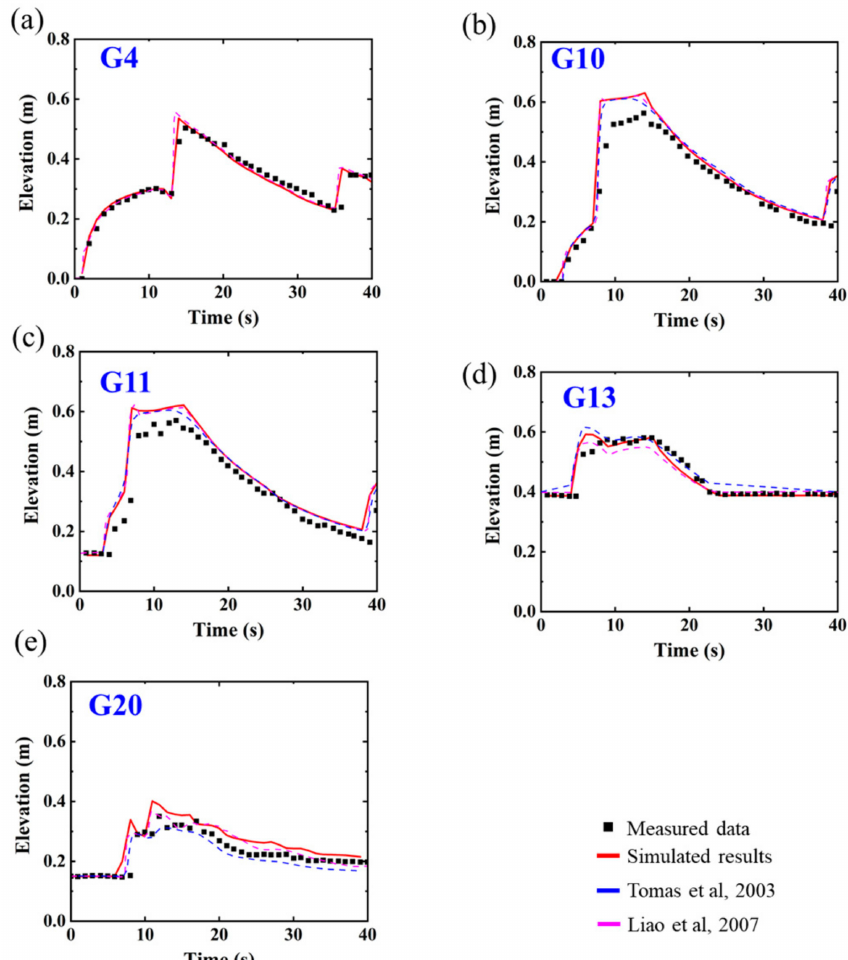
Figure 10. Monitored data compared with the simulated results at the four locations. ( a ) The simulated result is similar to the measured data at G4; ( b ) initially, the simulated results at G10 is lower but did not influence successive results; ( c ) the same higher simulated flow depth at G11 is similar to G10, a short-term lower elevation; ( d ) the simulated results fit well with the measured data at G13; ( e ) the simulated results fit well with the measured data at